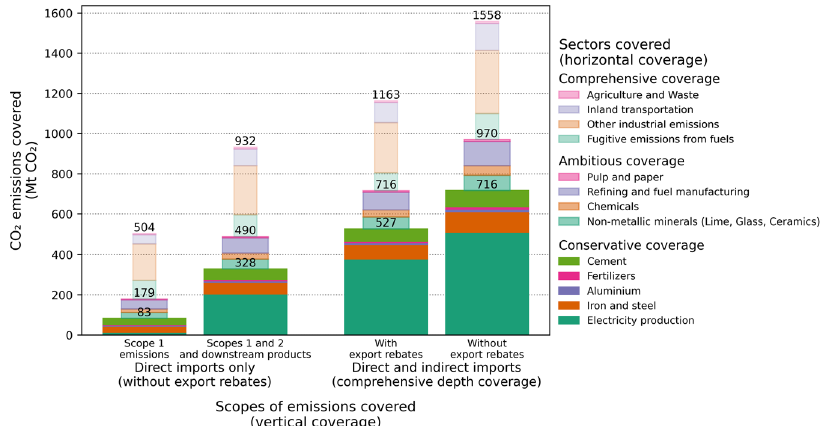
Fig. 1 CO 2 emissions covered by an EU CBAM under different implementation options. Bars show how much CO 2 emissions would be covered by an EU CBAM (assuming no trade adjustments), depending on the scope of emissions accounting (i.e., the number of layers in the supply chains included in emissions estimations - vertical coverage) and on the sectoral coverage (i.e., the sources of emissions covered by the EU CBAM — horizontal coverage). Four alternative vertical coverages are shown here. The option “ Scope 1 emissions ” only covers emissions directly caused by imports to the EU. Option “ Scopes 1 and 2 and downstream products ” also includes the emissions of the direct suppliers of exporters to the EU. These two implementation options are in line with the current EU CBAM proposal. By contrast, the “ Direct and indirect imports ” options account for all upstream emissions caused along the supply chains used to produce exports to the EU. In the setting “ With export rebates ” , emissions caused by EU imports for producing goods that are further exported from the EU are excluded from the EU CBAM coverage. Estimated CO 2 emissions are detailed based on the process causing them (see Methods and Data). These processes are grouped into three horizontal coverage aggregates. The “ Conservative coverage ” category (dark, wide blocks) entails emissions that are explicitly addressed in the EU CBAM proposal. These provide a lower bound estimate of the emissions that would be covered by the current EU CBAM proposal. Sectors included in the “ Ambitious coverage ” category (half-transparent, medium width blocks) are processes covered by the current EU ETS which may eventually be covered by the EU CBAM as well. The sum of the emissions covered in the conservative and ambitious categories form together the upper bound of a sectoral coverage in line with current EU CBAM policy proposal. Adding light and thin blocks forms a “ Comprehensive coverage ” category, which would cover all sectors and all sources of emissions and hence corresponds to an extension of the CBAM to all industrial emissions. All data refer to 2016. International transportation-, land use- and fi nal use-related emissions are not included here. Detailed data points are provided in Supplementary Table 1. Supplementary Table 2 details the processes covered in the different horizontal